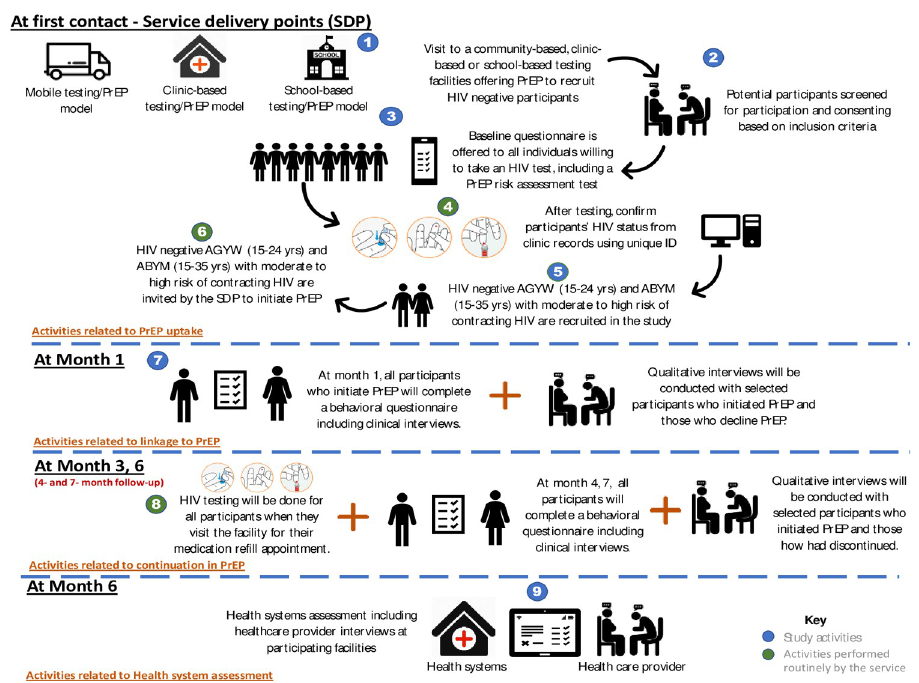
Fig 2. An illustration of the study activities for the SHeS’Cap-PrEP study in uMgungundlovu district, KZN,